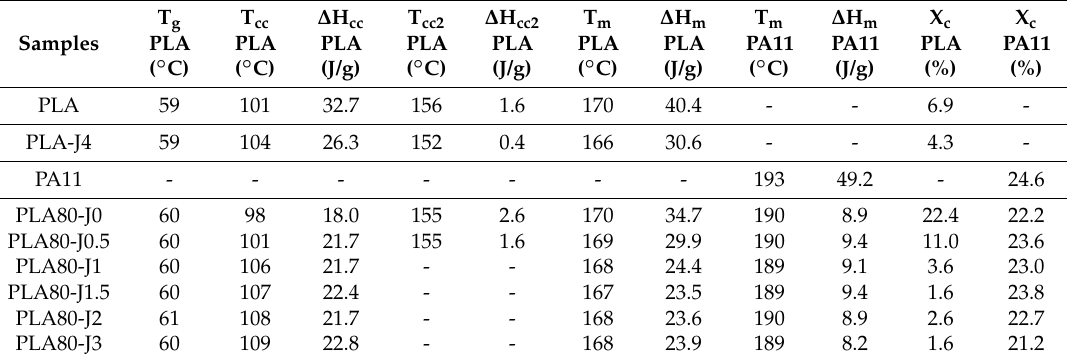
Table 2. DSC results obtained from the second heating